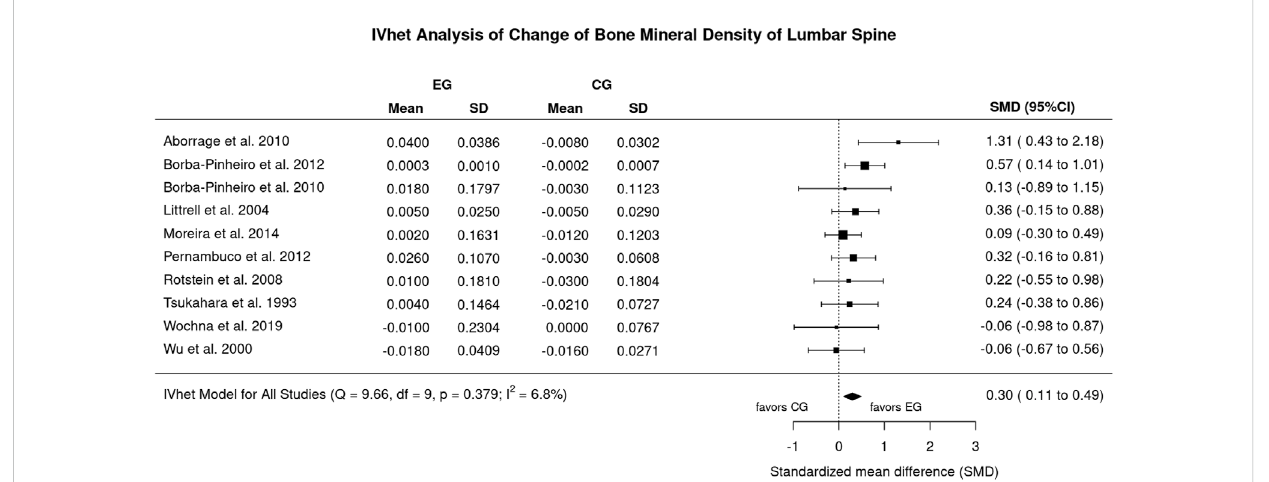
Forestplotofmeta-analysisresults ofallincludedtrialsatthelumbarspine.Data shownaspooledstandardizedmeandifference(SMD)with95%-CI for changes in the, EG versus the CG.